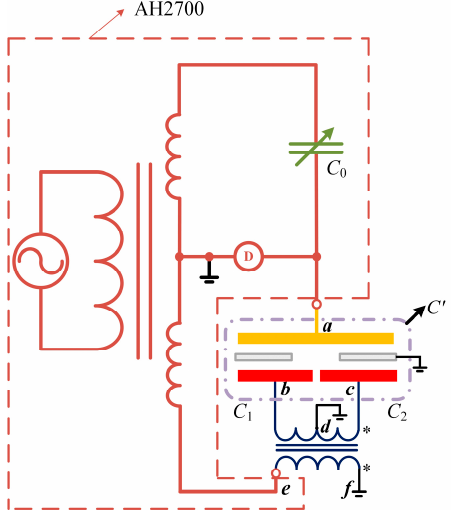
Figure 5. Schematic of the differential capacitance measurement circuit.